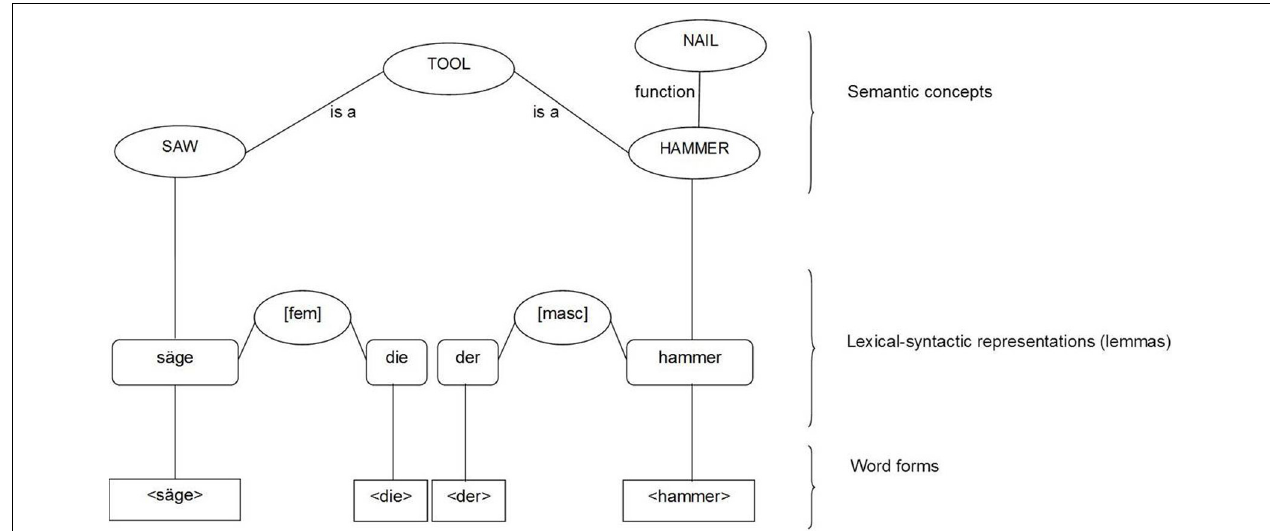
FIGURE 4 | Illustration of the different representations of the German nouns “Hammer” (hammer) and “Säge” (saw) at each level in Levelt et al.’s (1999) theory. For the sake of clarity not all links are shown.